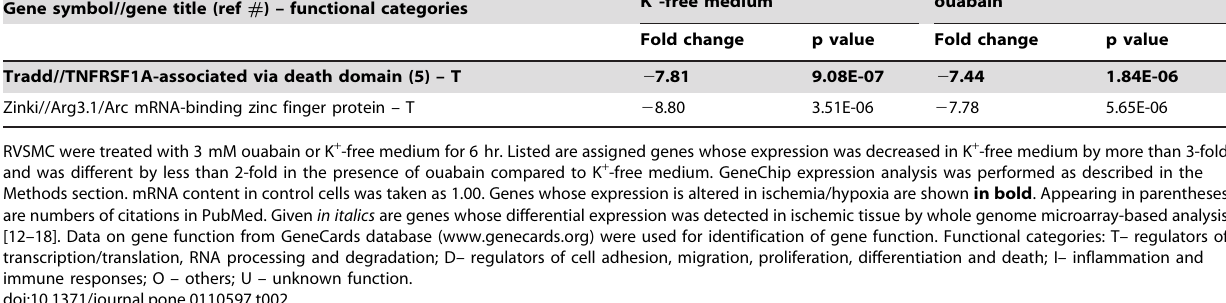
Gene symbol//gene title (ref # ) – functional categories